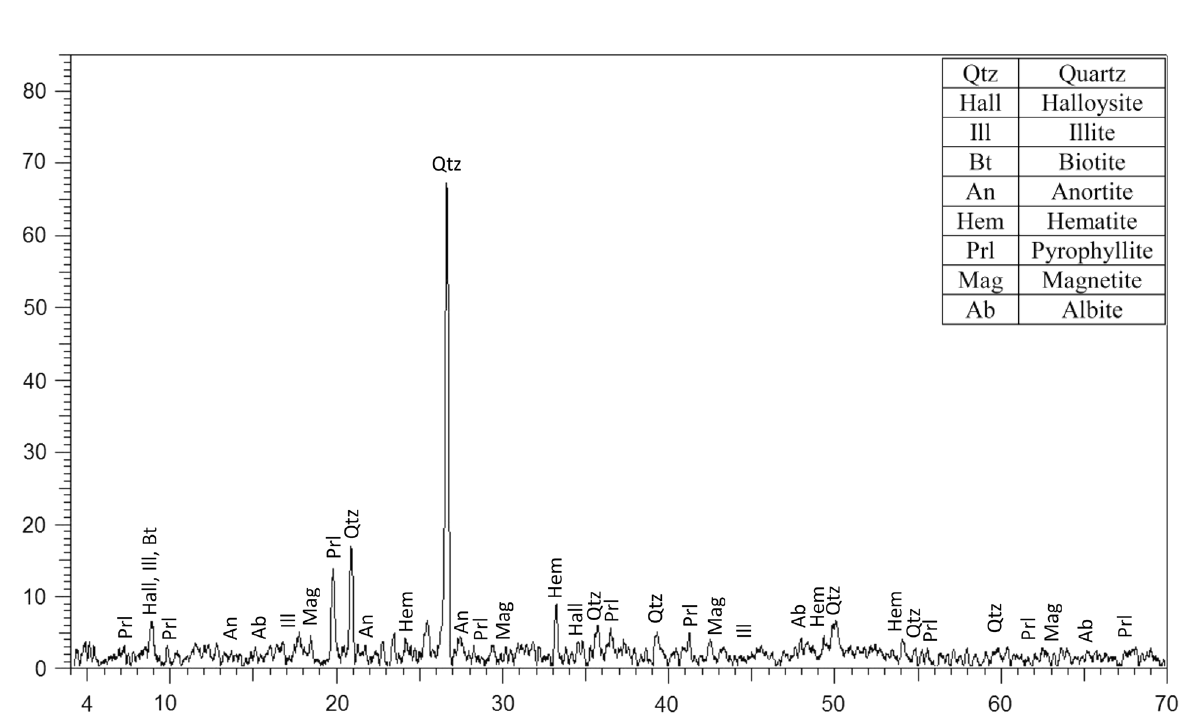
Fig. 1 X-ray diffraction pattern of